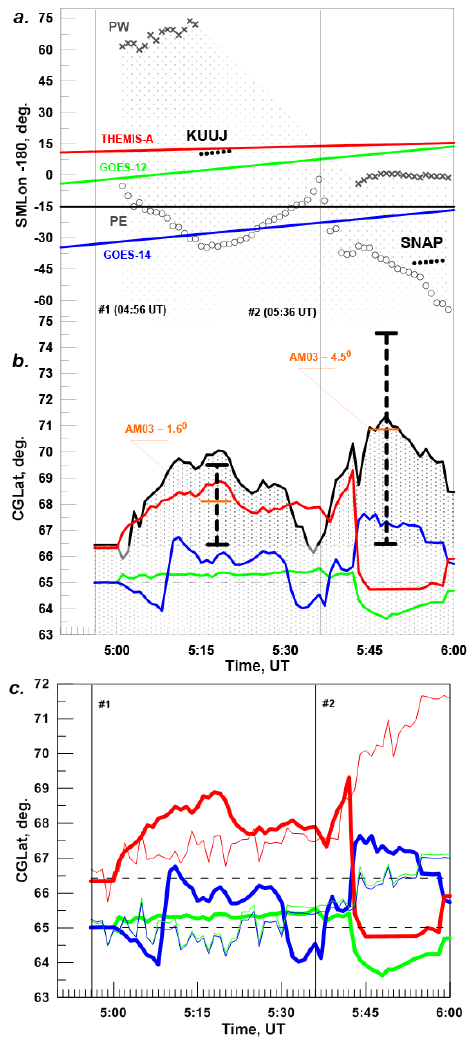
Figure 8. (a) THEMIS and GOES spacecraft, KUUJ and SNAP sta- tion locations relative to SCW; (b) CGLat variations of spacecraft ionospheric footpoints caused by SCW2L (colored solid lines) dur- ing activations no. 1 and no. 2; (c) comparison of CGLat footprints variations predicted by the SCW2L (thick lines) and time-varying adaptive AM03 models (thin lines). The black line in panel (b) indi- cates the ionospheric position of dummy spacecraft at X =− 11Re, Y = 3Re, and Z =− 1.56Re (neutral sheet, see also black square in Fig. 7a and b). Vertical bars illustrate the amplitude of the auro- ral poleward expansion observed by FSMI and SNAP ground mag- netometers. The ginger notches show AM03 predictions (at dipo- larization peaks) for the dummy spacecraft located at R = 11Re. The footprint calculation time covers both dipolarizations from T = 04:30 to 05:58UT.